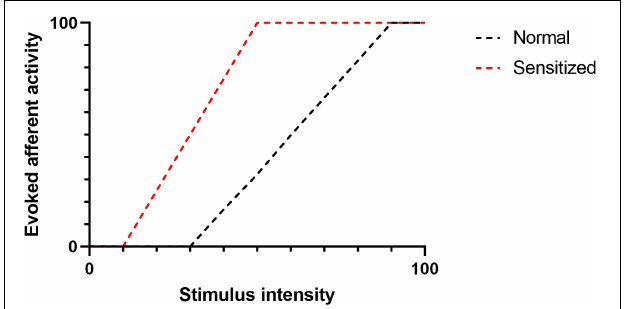
FIGURE 2 | The figure illustrates evoked afferent nerve activity as a factor of stimulus intensity. Following sensitization (e.g., TRP-Eicosanoid binding), the activation threshold (intersection of a curve with the X -axis) is reduced. Similarly, the magnitude of the afferent response to a given stimulus is